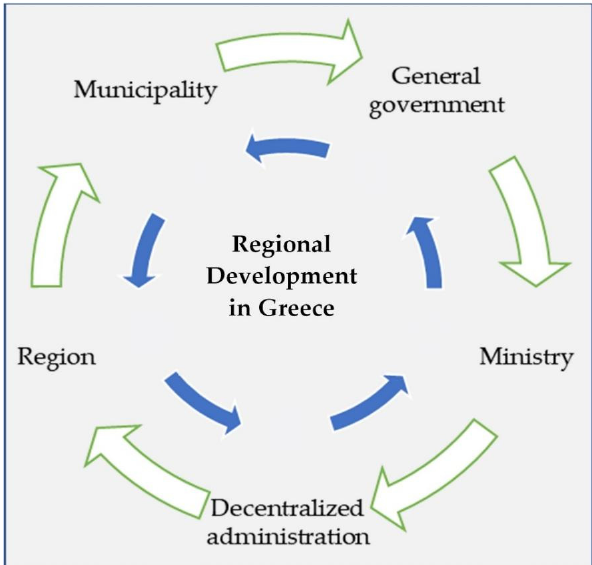
Figure 1. Greek administrative structure of rural and local development. Source: Authors’ scheme.